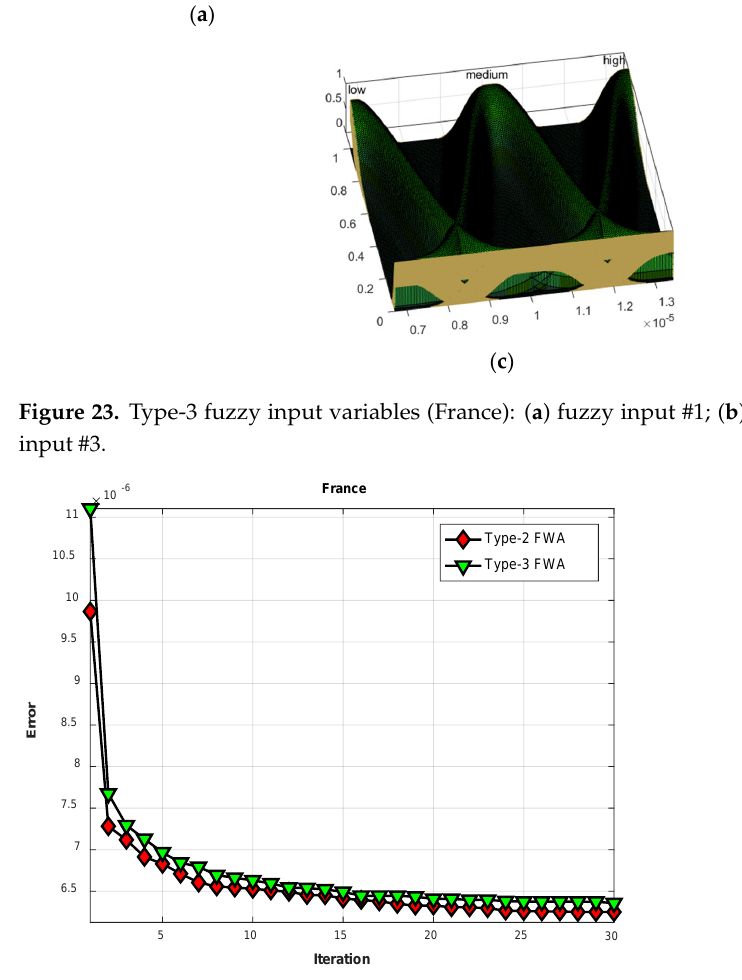
Figure 24. Average convergence for France.